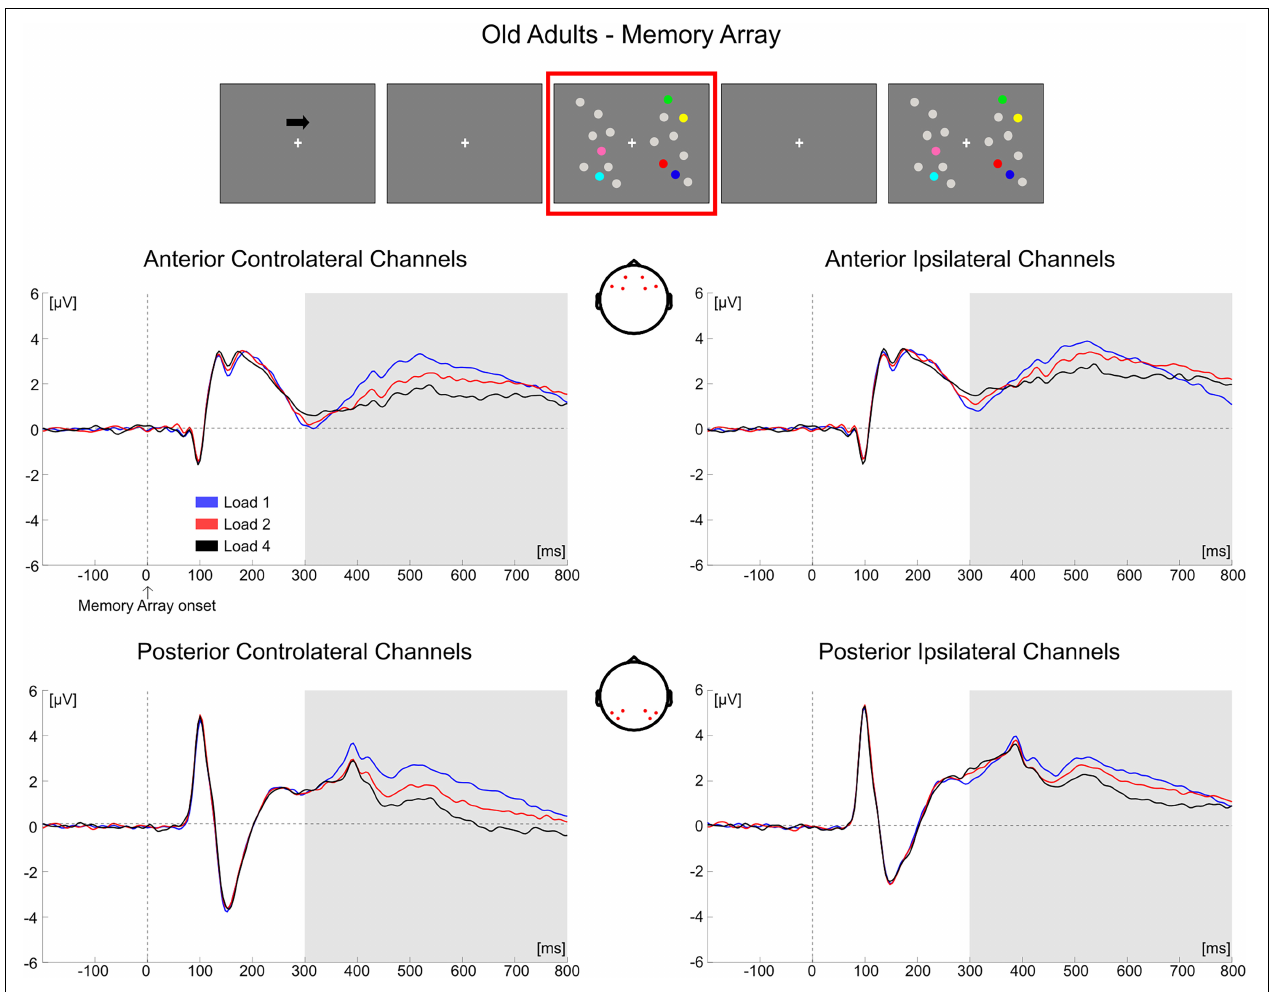
FIGURE 6 | Grand average waveforms as a function of target load over the anterior (Fp1/2, F3/4, F7/8) and posterior ROI (P7/8, PO7/8, P3/4), separately for contra- and ipsilateral to target channels, in the Older group during memory retention. Topographies highlight the channels included in the ROIs and gray squares indicate the TOIs over which the mean amplitude was